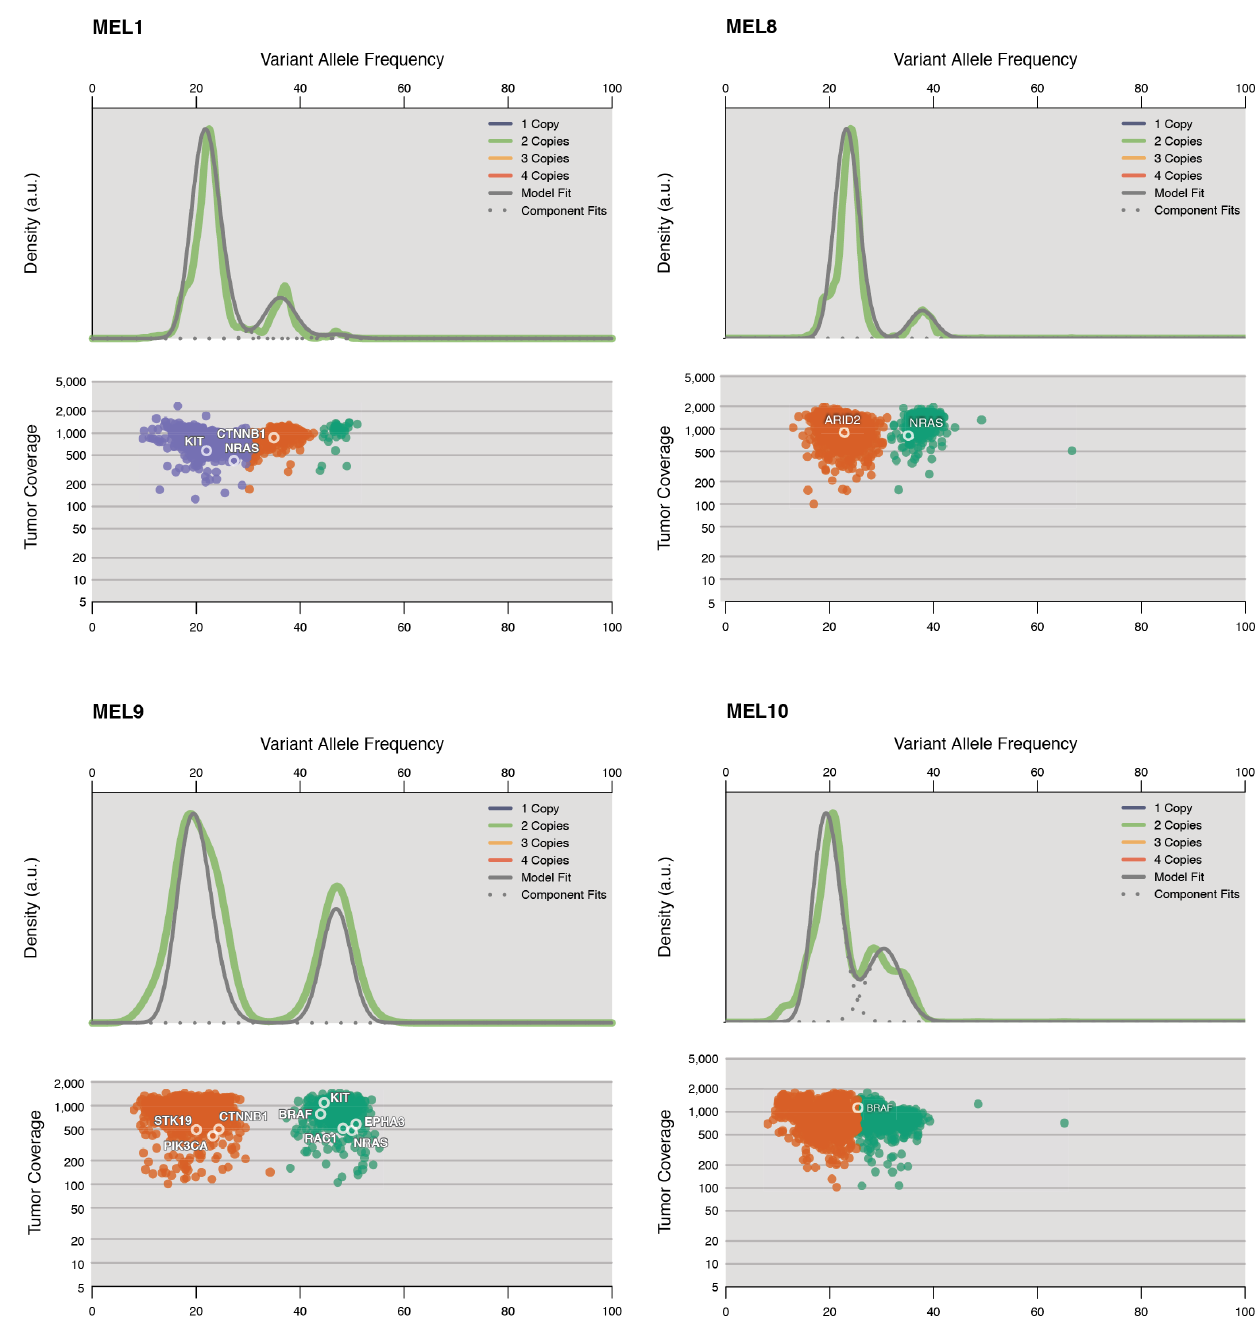
Figure 3. Overview of subclonal landscape in melanoma (MEL1, 8, 9, and 10) and their associated driver mutations. Two plots are shown for each case: kernel density (top), followed by the plot of tumor variant allele frequency by sequence depth for sites from selected copy number neutral regions (see Methods). Data shown are from chromosomes 1, 3, 4, 6, 10, and 13 for MEL1, from chromosomes 1, 2, 5, 12, and 20 for MEL8, from chromosomes 1, 3, 4, 6, 7, 12, and 13 for MEL9, and from chromosomes 6, 7, 10, 13, and 15 for MEL10. The data show evidence of two clusters in MEL1, MEL8, MEL9 and MEL10 with the majority of mutations from the lower allele frequency clusters. Mutations detected in significantly mutated genes in this study and genes implicated in Hodis et al . [18] were labeled. doi:10.1371/journal.pone.0111153.g003 patterns were almost identical for the MEL13 paired metachro- the lung (22.2% and 14.3%) and pancreas (45.6% and 39.4%) nous tumors from chest wall and lung ( Figure 5 ). In MEL5, a metastasis from MEL5 ( Figure 6 and Table S12b–c in File significant number of inversions on chromosome 3 were found to S2 ). The MEL5 lung metastasis has two distinct mutation clusters, be present in the pancreatic metastasis but not the lung metastasis while the pancreas metastasis harbors two clusters with overlap- ( Figure 5 ). Clonality analysis using point mutations from selected ping boundaries. A comparison of genome-wide tier 1 mutations copy number neutral regions revealed at least two clusters each in in the pancreas versus lung metastases ( Figure 6 and Table